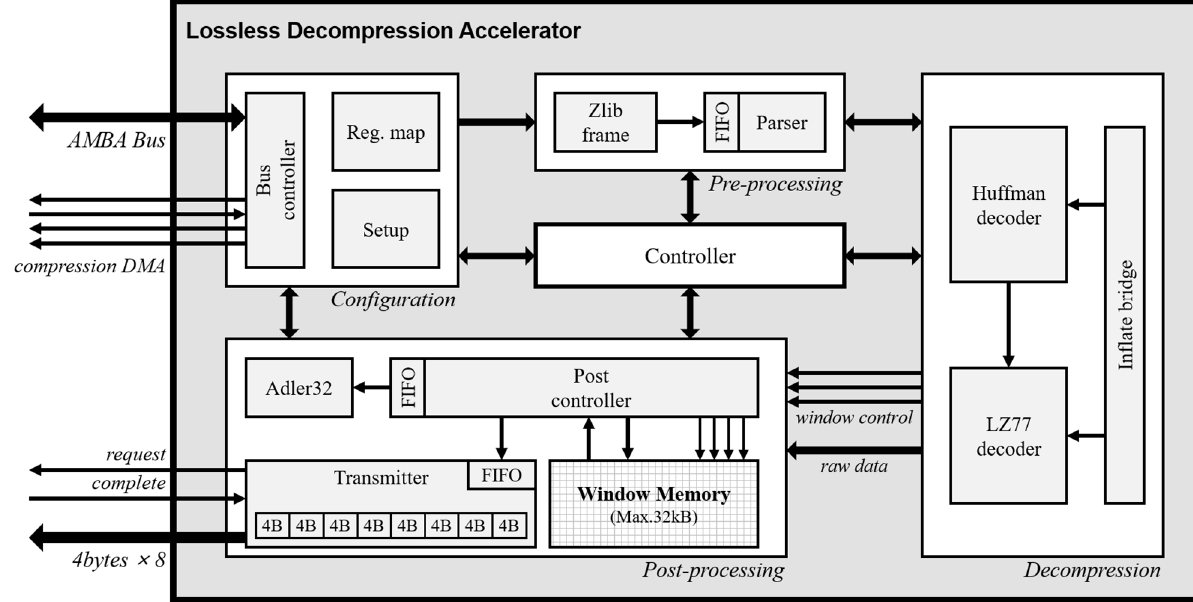
Figure 2. Block diagram of lossless decompression accelerator (LDA).